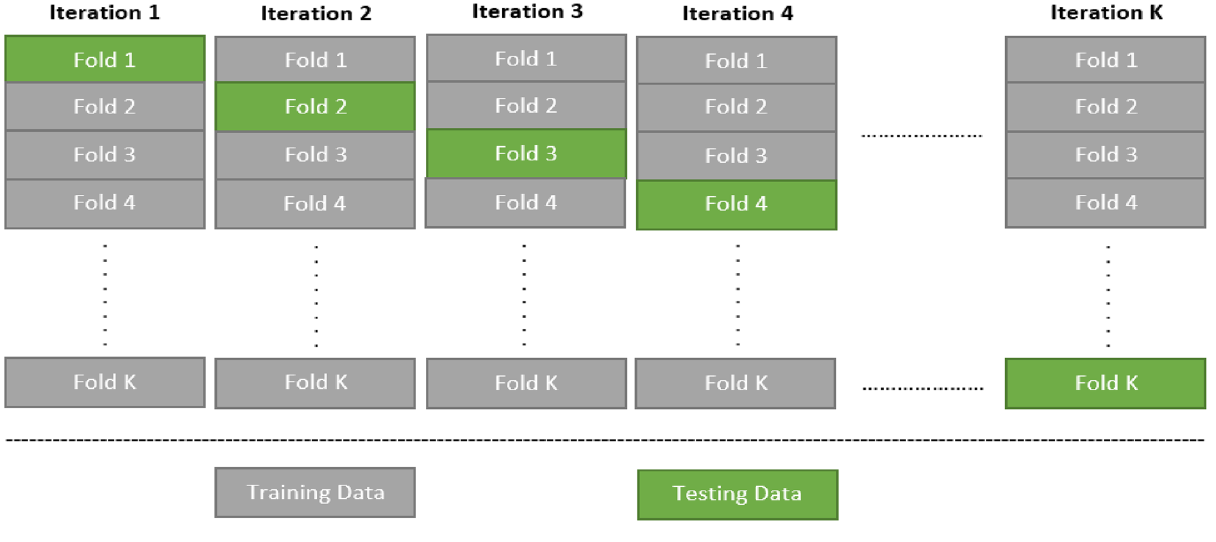
Figure 6. Block diagram of K-fold